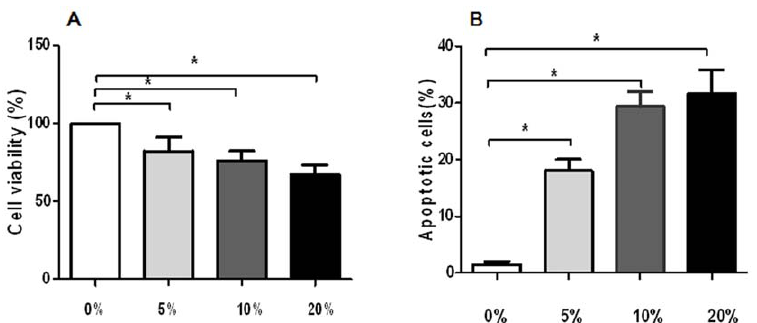
Figure 7. Invitro toxicities of PBMC supernatant against keratinocytes. HaCat cells were incubated with culture medium alone or culture medium containing 5%, 10%, 20% PBMC supernatants for 24 hours. A. MTT assays showed that the supernatants of drug-stimulated PBMCs were cytotoxic against keratinocytes in a dose-dependent manner. B. Annexin V staining showed that the supernatants of drug-stimulated PBMCs induced apoptosis of keratinocytes in a dose – dependent manner. * P , 0.05 .